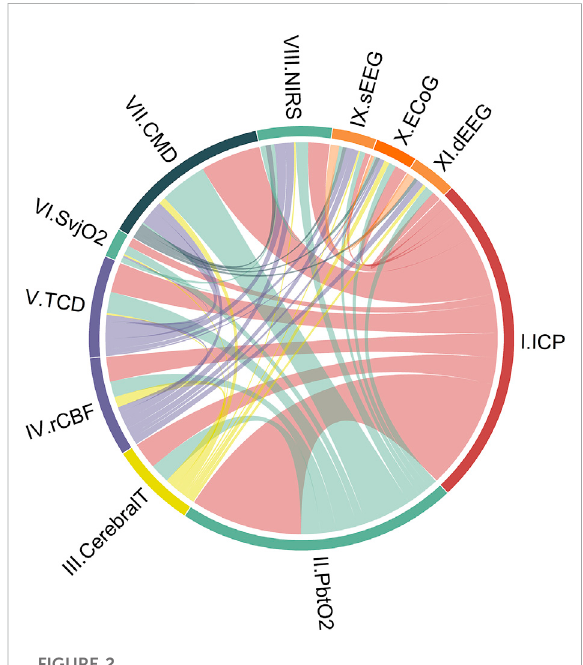
FIGURE 2 Combinations of cerebral unimodal monitoring modalities in the literature over the last 7 years (112 studies). Circos-plot visualizing connections between unimodal continuous cerebral monitoring modalities. ICP monitoring is the modality most combined, followed by PbtO 2 . As an illustration to understand the distribution of each part: ICP monitoring appears in study 1 in combination with modalities II and III, and in study 2, ICP appears withmodalitiesIVandV.ICPmonitoringisthendisplayedon2/6of thecircle(ICP+ICP+II+III+IV+V,6ofwhich2xICP).Thecolors represent intracranial volume (red), cerebral oxygenation (green), regional cerebral blood fl ow (purple), cerebral metabolism (dark blue), neuronal electrical activity (orange), and cerebral temperature (yellow). Cerebral T, cerebral temperature; CMD, cerebral microdialysis; dEEG, depth electroencephalography; ECoG, electrocorticography; ICP, intracranial pressure; NIRS, near-infrared spectroscopy; PbtO 2 , partial pressure of brain tissue oxygenation; rCBF, regional cerebral blood fl ow; sEEG, surface electroencephalography; SvjO 2 , jugular bulb venous oximetry; TCD, transcranial